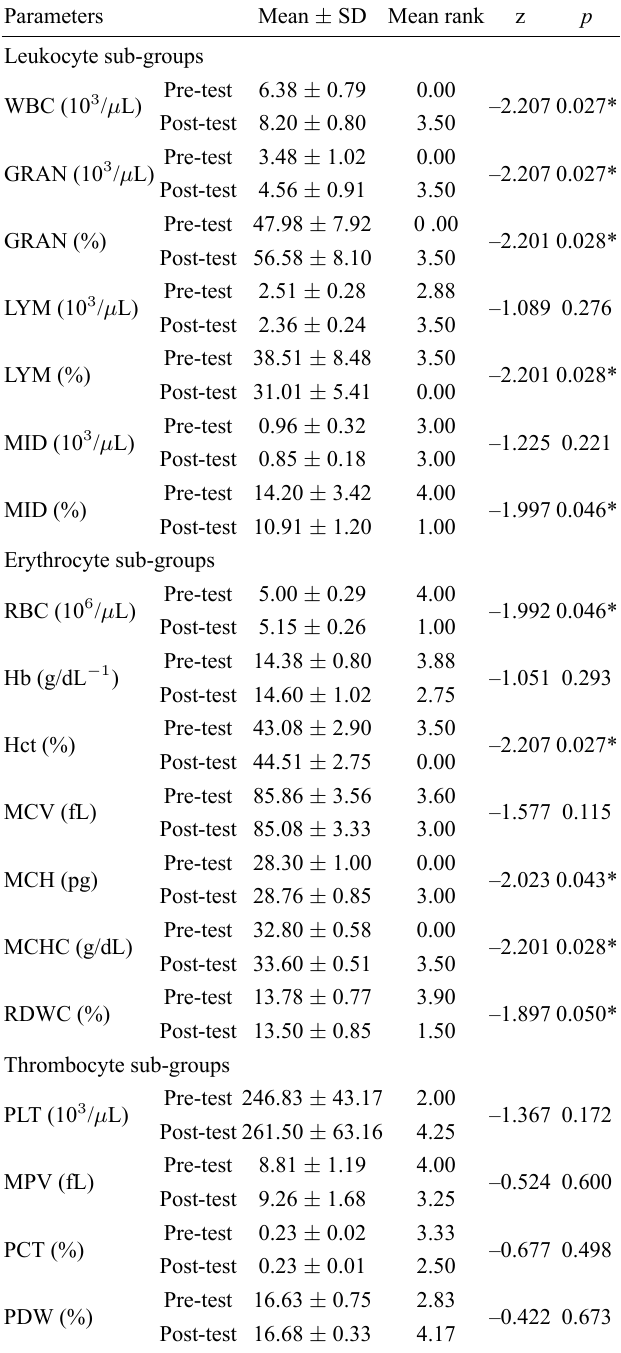
Table 2. Hematological parameter changes before and after the acute moderate-intensity training in male athletes (mean ± standard deviation) (n =